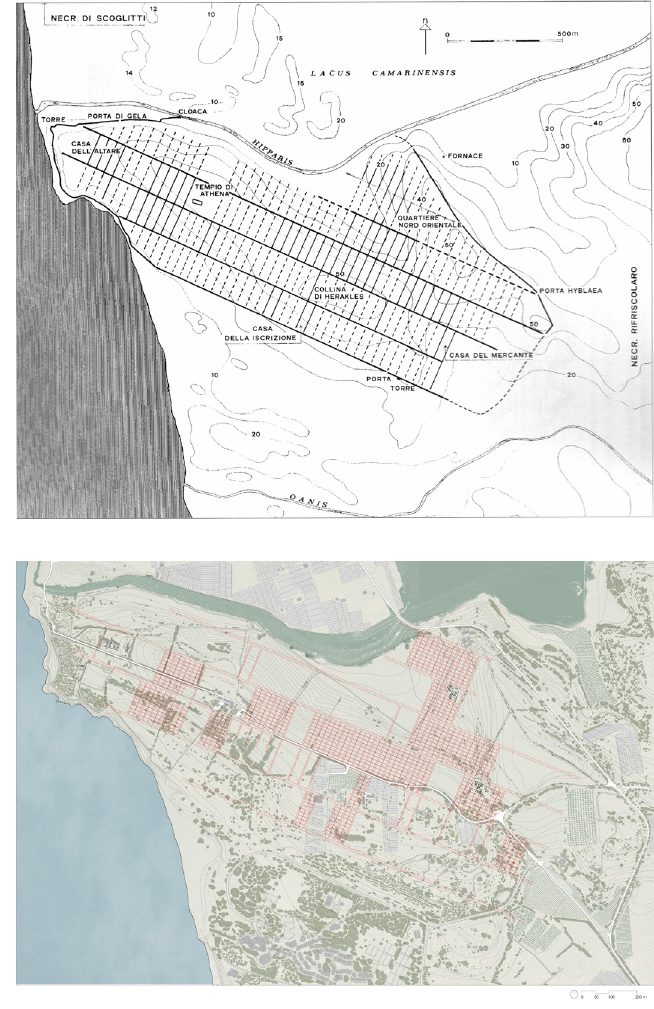
Fig. 13 Kamarina, planimetric diagram (Pelagatti, 1974).